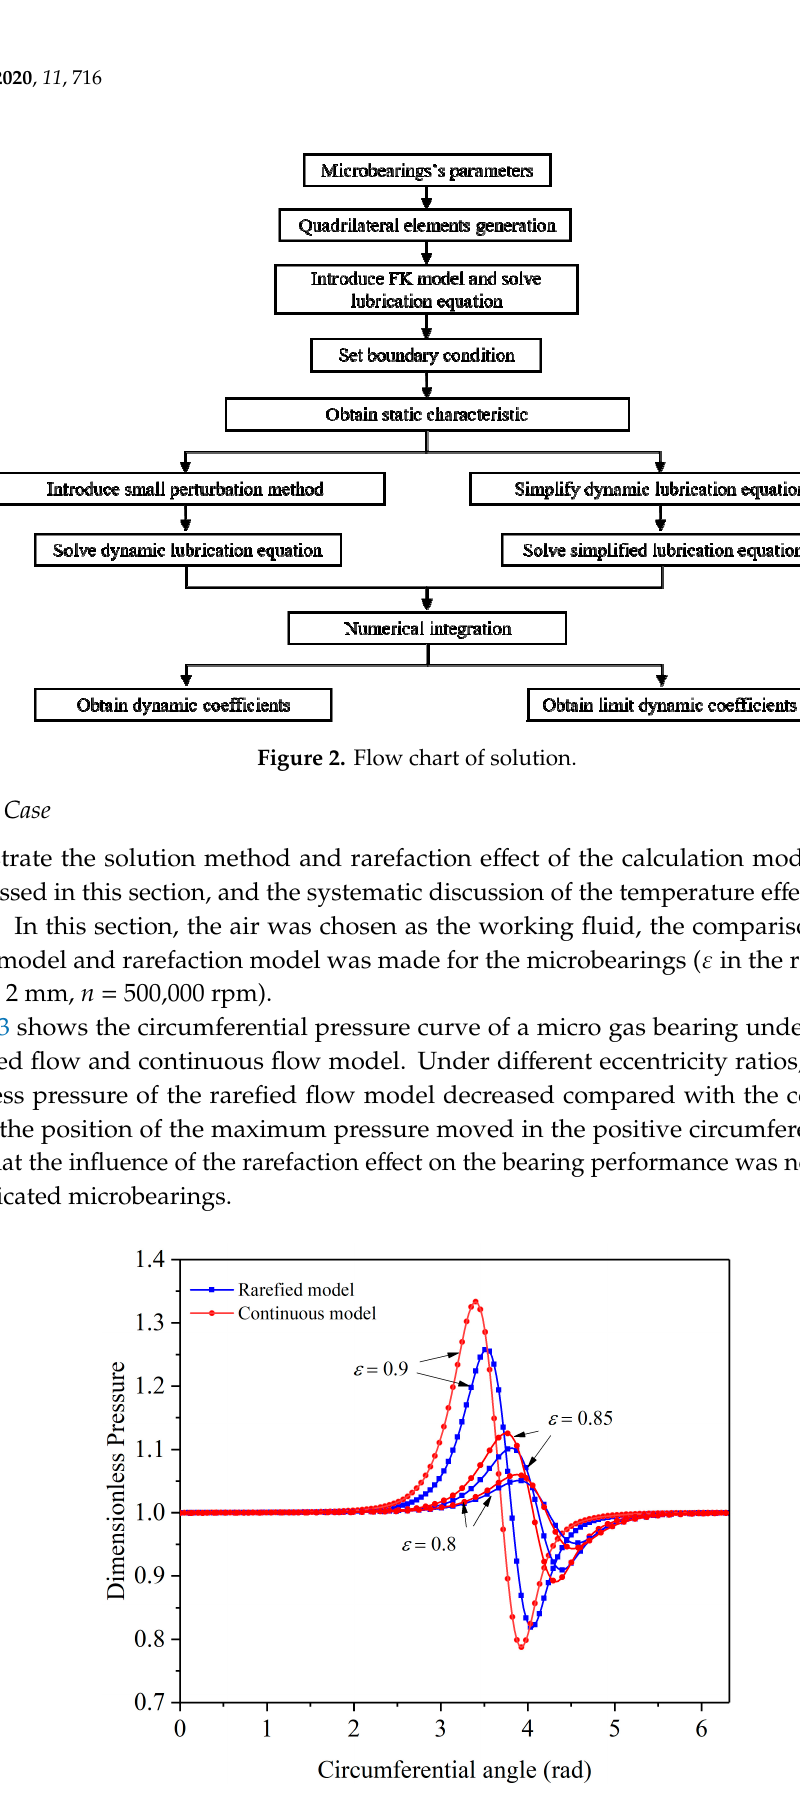
Figure 3. Center pressure comparison of two flow models.